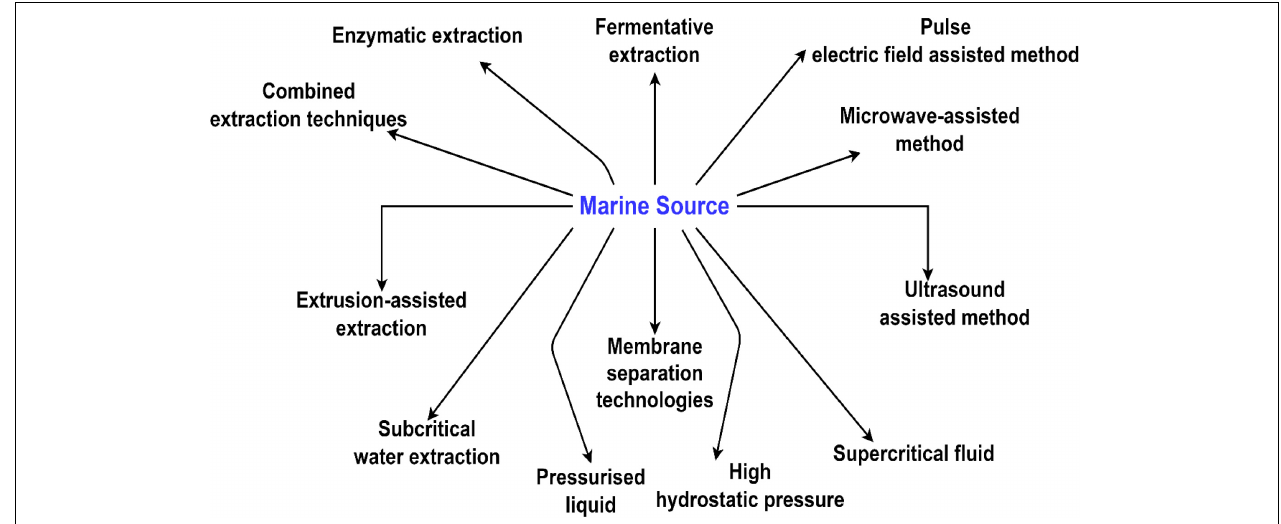
FIGURE 3 | Classification of sustainable green processing methods to extract biomolecules from different marine